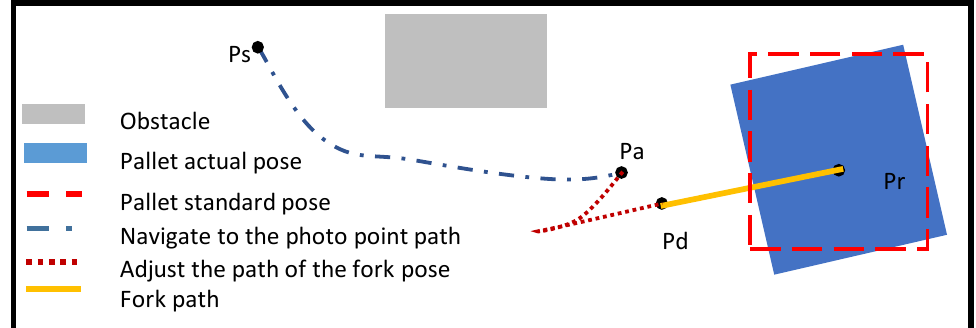
Figure 14. Schematic diagram of the fork experiment process.